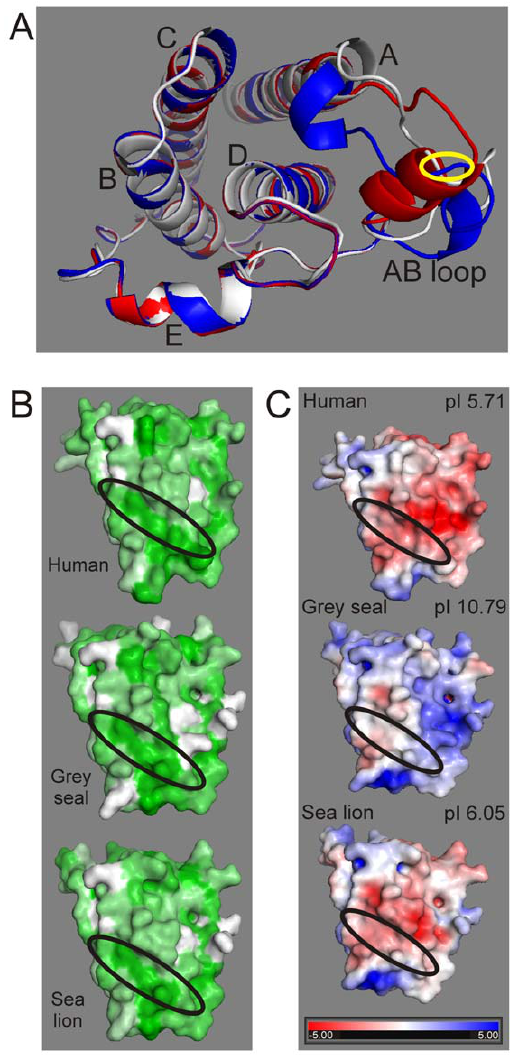
Figure 3. Conserved tertiary structure within mammalian leptins. (A) Ribbon models based on complete human (white, PDB coordinate file kindly provided by Prof. F. Zhang), grey seal (blue), and California sea lion (red) models are overlaid and show the conserved tertiary structure of the Helices A to E and the position of the variable AB loop. Structural prediction based on the crystallographic structure for human leptin, PDB ID: 1AX8, using SWISS-Model [38]. The position of the additional cysteine (Cys 31 ) predicted in the phocid seal sequence is identified by the yellow ellipse within the AB loop; this substitution has no significant effect on the overall tertiary structure of the molecule. (B) Conservation of the hydrophobic leptin receptor (LEPR)-binding cleft across terrestrial and marine mammal leptin molecules. Figure shows the predicted surface hydrophobicity for human, grey seal and California sea lion (green=hydrophobic, white=hydrophilic) with the binding cleft circled by a black ellipse in each image. (C) Distribution of surface electrostatic potential of phocid seal leptin is markedly different to that of other marine and terrestrial mammals, especially away from the hydrophobic LEPR binding cleft. Figure shows Poisson–Boltzmann electrostatic surface potential of solvent-exposed surfaces coloured from red ( 2 5.0) to blue ( + 5.0) for predicted leptin structures for the human, grey seal and California sea lion as well as the predicted isoelectric point (pI) for each molecule. Residue substitution in grey seal leptin produces a more neutral hydrophobic cleft and a considerably more electropositive surface elsewhere on the molecule than in the case of the human and California sea lion.